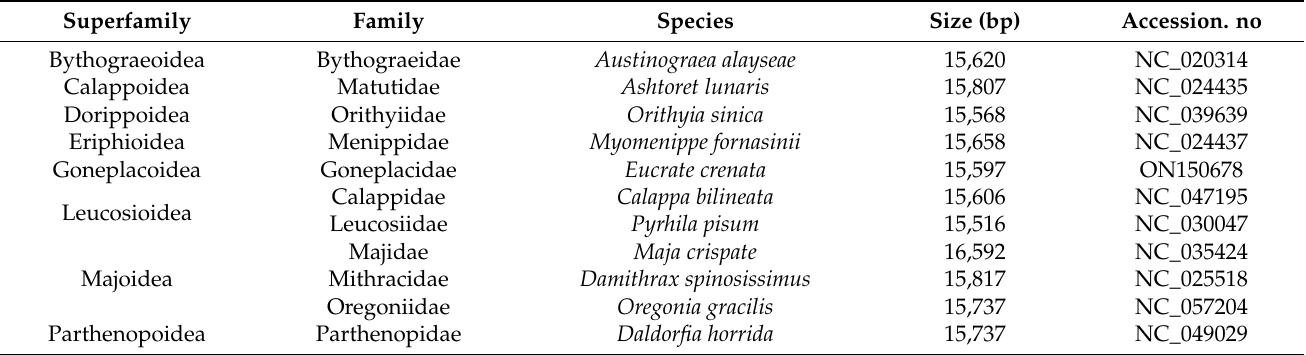
Table 1. List of Brachyuran species with their GenBank accession